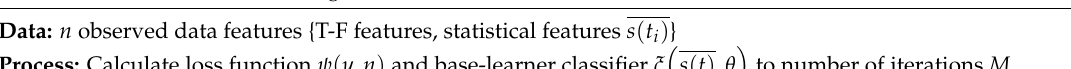
Table 3. Gradient boosting machine classifier in pseudocode. ALGORITHM : Gradient Boosting Machine